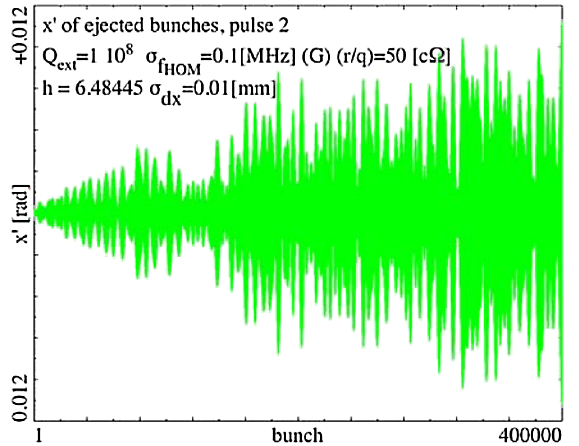
FIG. 49. (Color) x 0 [rad] corresponding to Fig. 48.